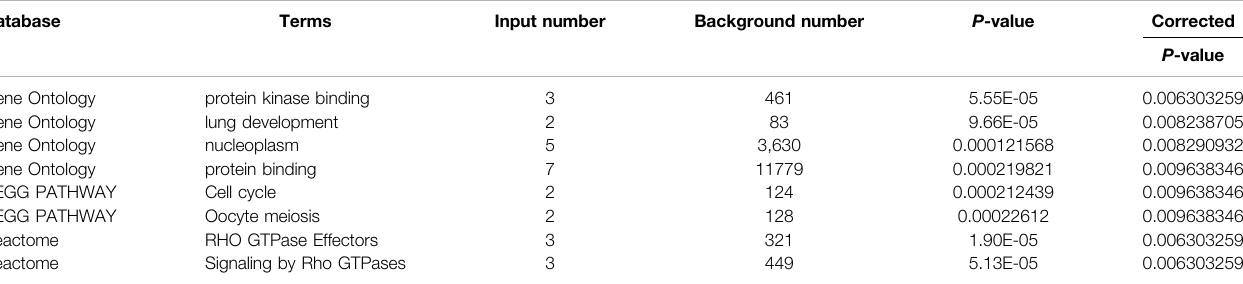
TABLE 4 | Signi fi cant GO annotation, KEGG, and Reactome pathways of the seven core